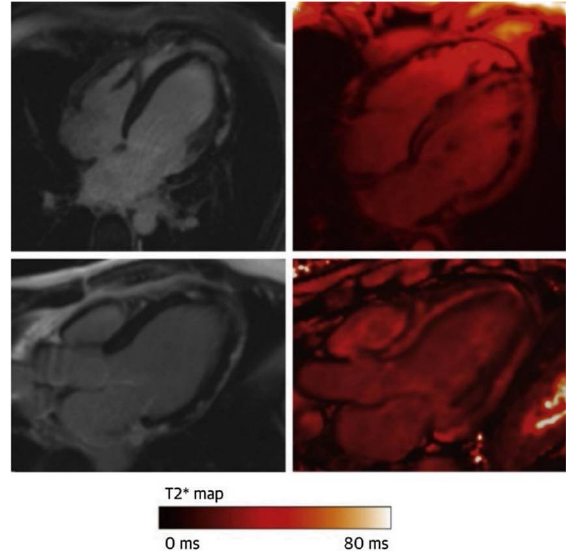
Figure 3. An example of a patient with acute myocarditis showing sub-epicardial LGE inferiorly and inferolaterally on 4-chamber and 3-chamber views (left) but no evidence of ferumoxytol uptake within the regions displaying LGE 24 h following infusion (right). CMR = cardiac magnetic reso- nance; LGE = late gadolinium enhancement. Reproduced with permission from Merinopoulos et al.